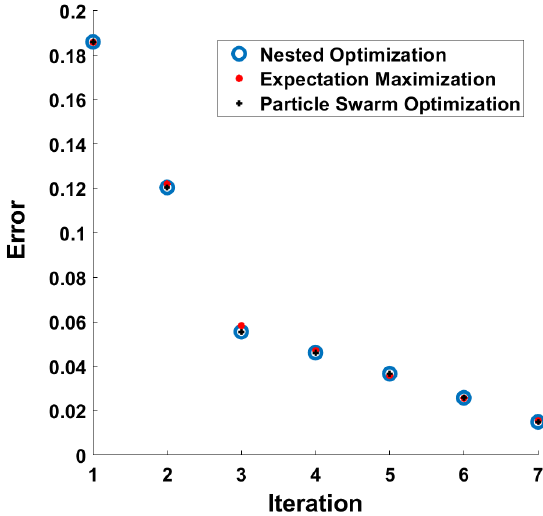
Figure 8. The loss function and model partition for PSO algorithm after iteration 1. ( a ) Loss function. ( b ) Model partition.